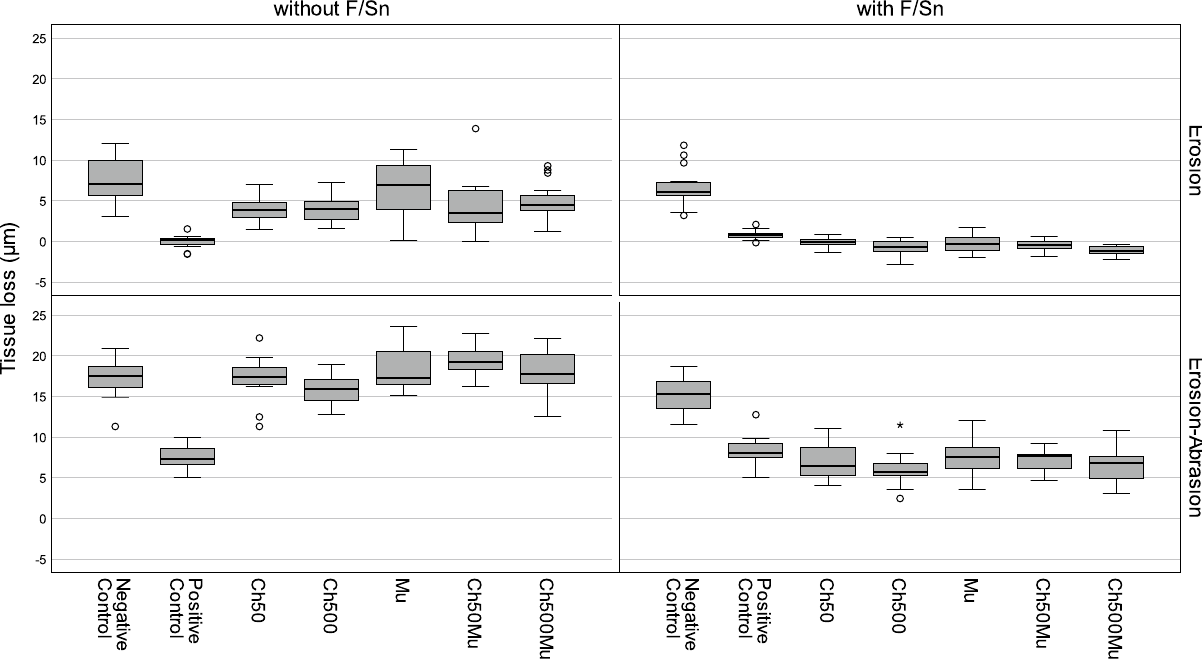
Figure 1. Box-whisker-plots of the profilometric tissue loss (µm). The left diagrams show results from experiment 1 in which F/Sn was only used in the positive control, the right diagrams show results from experiment 2 in which F/Sn was applied in all groups except for the negative control. The upper diagrams show groups only treated with citric acid solution (erosion), the lower diagrams show groups which were additionally abraded (erosion-abrasion). Negative Control = without active agents; Positive Control = F/Sn only; Ch50/Ch500 = chitosan with viscosities of 50 mPas/500 mPas; Mu = porcine gastric mucin; Ch50Mu/ Ch500Mu = combination of chitosan and mucin in separate solutions (application order chitosan first, mucin second). The circles represent outliers that lie within the 1.5- to 3-fold interquartile distance, asterisks represent extreme values that lie outside of the threefold interquartile